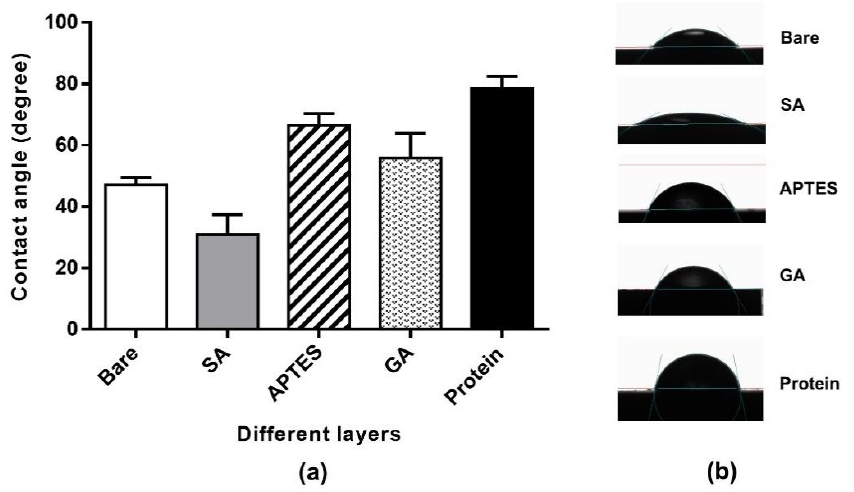
Figure 1. The measurements of static CA on Si 3 N 4 surface in each step of surface modification and antigen immobilization process. ( a ) Bare; the native Si 3 N 4 surface without any treatment, SA; surface activation, APTES; Si 3 N 4 surface after modification with 1% APTES for 1 h, GA; Si 3 N 4 surface after modification with 2.5% GA for 1 h. Protein; the surface after 20 µ g/mL of HLA-A protein immobilization. ( b ) The illustration of the water droplets on the different silicon nitride substrates in each step of surface modification.